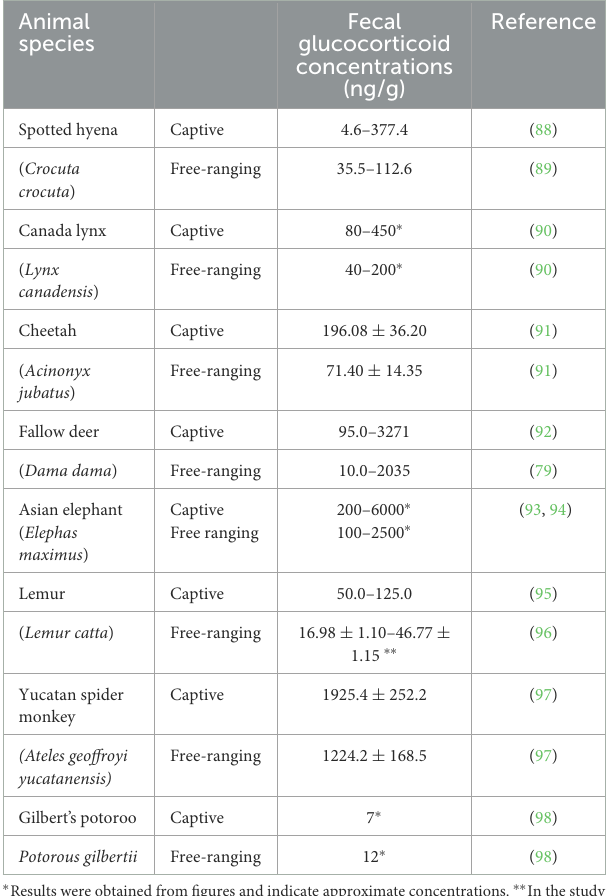
TABLE 3 Fecal glucocorticoid concentrations in some captive and free-ranging species. Animal